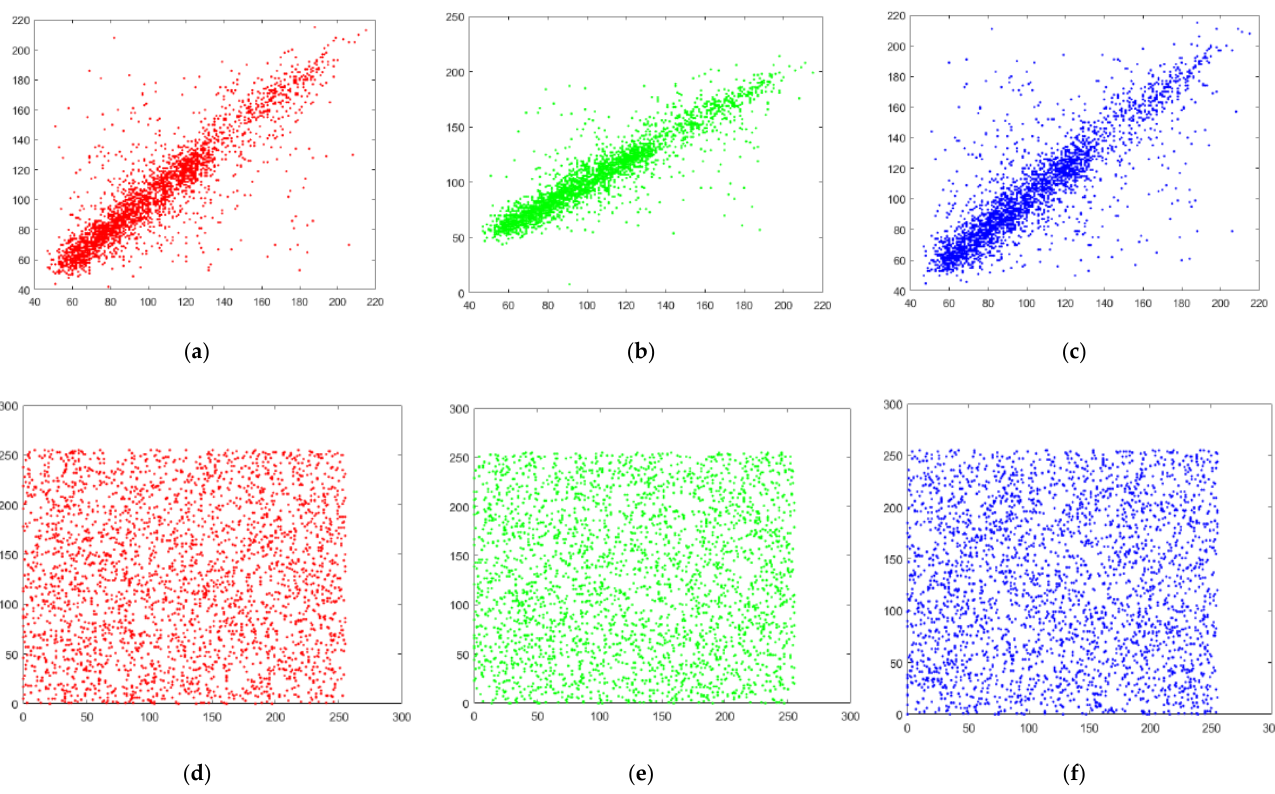
Figure 6. Correlation distribution: ( a , d ) Horizontal distribution in the red channel of the plain and cipher images; ( b , e ) Ver-